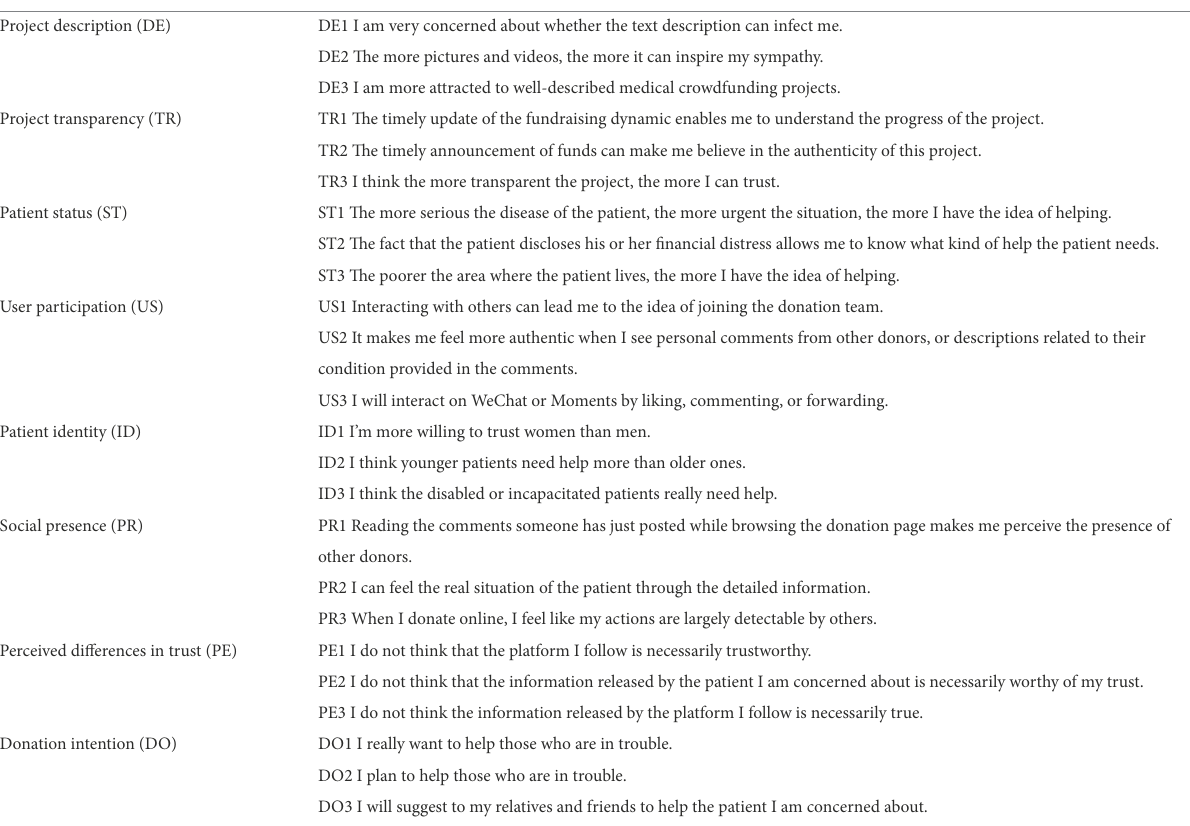
TABLE 1 Measuring items of